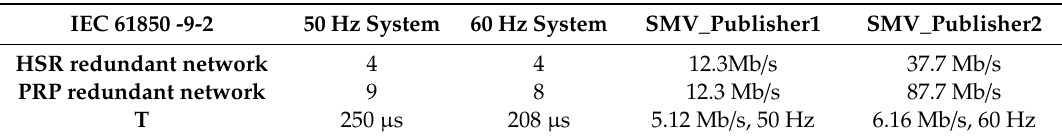
Figure 13. Number of packets per ms for IED publisher/CMC MU. Table 5. PTP time synchronization and